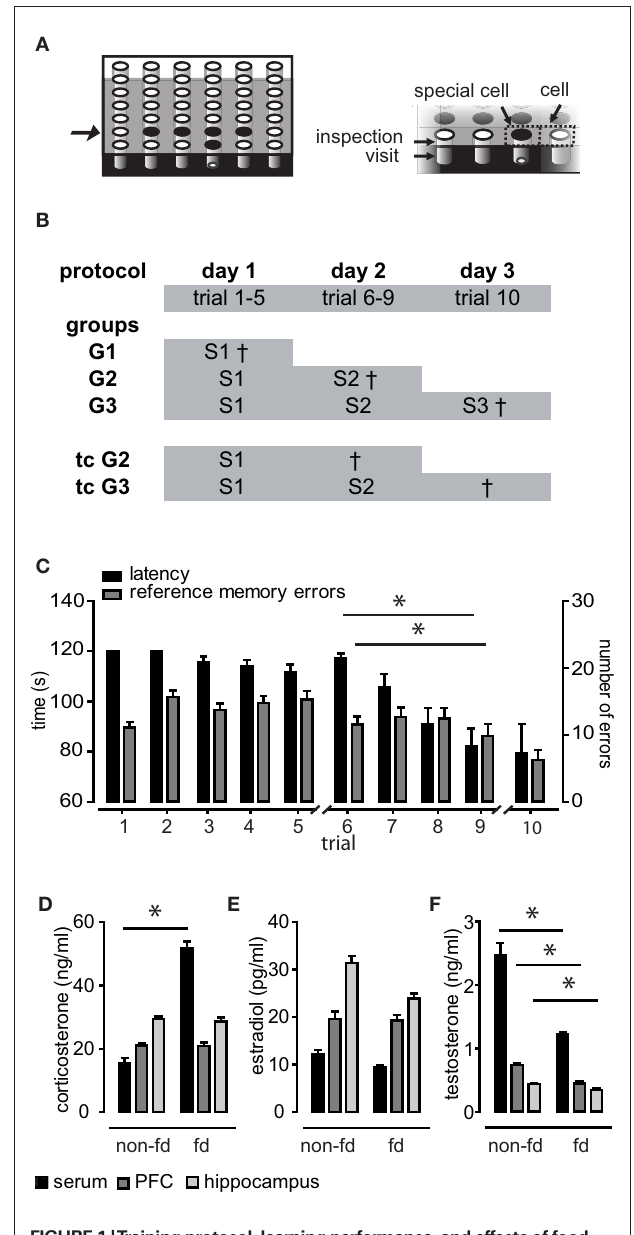
Figure 1 | Training protocol, learning performance, and effects of food deprivation on hormone household. (A) The same five of 36 holes of the holeboard were baited (depicted in black). The right panel illustrates behavioral parameters. Breaking light beams of the holes was classified as either inspection of the hole (upper beam) or visit (middle beam). Areas surrounding the holes were termed “cells” or “special cells” in case of baited holes. In (B) the protocol and the training groups for hormone sampling are depicted. The full training protocol consisted of three sessions (abbreviated with S). Three training groups (G1–3) were sacrificed 15 min after the session and two trained control groups (tcG2 and tcG3) were sacrificed 24 h after the session. (C) Averaged performance as measured in latency to find all pellets and reference memory errors (RME). Animals performed significantly better at the end of session 2 as compared to the beginning. (D) Food deprivation (fd) caused significantly elevated corticosterone serum levels as well as reduced testosterone levels (F) in blood as well as in brain tissue samples. (e) Estradiol levels were not significantly affected by food